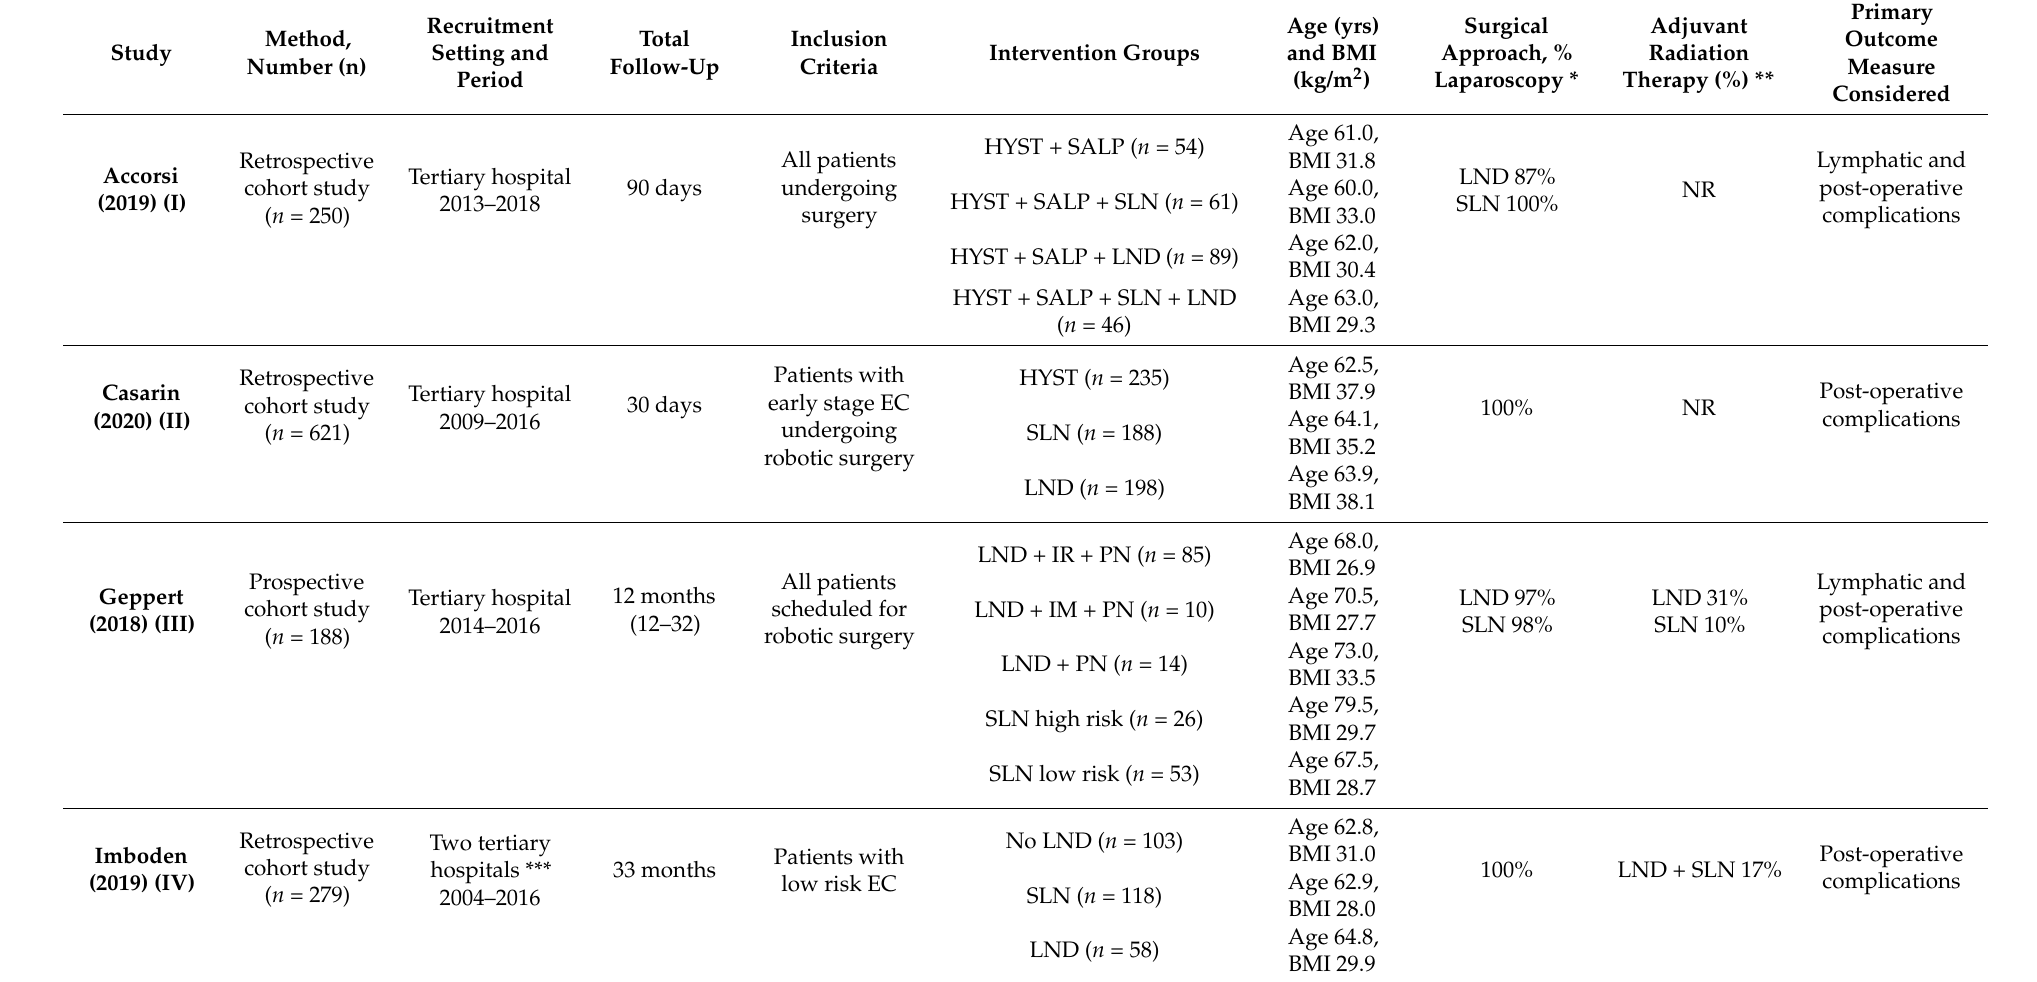
Table 2. Descriptive characteristics of the included